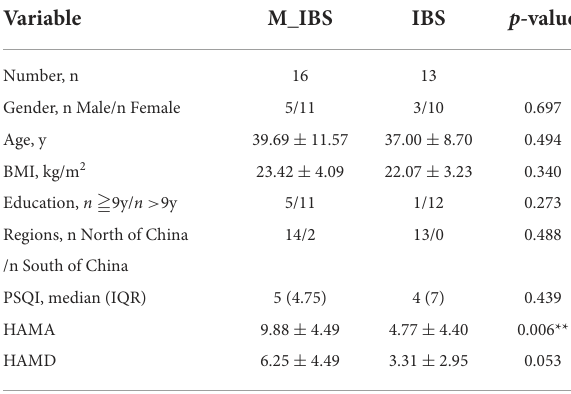
TABLE 1 Demographic characteristics in the M_IBS and IBS